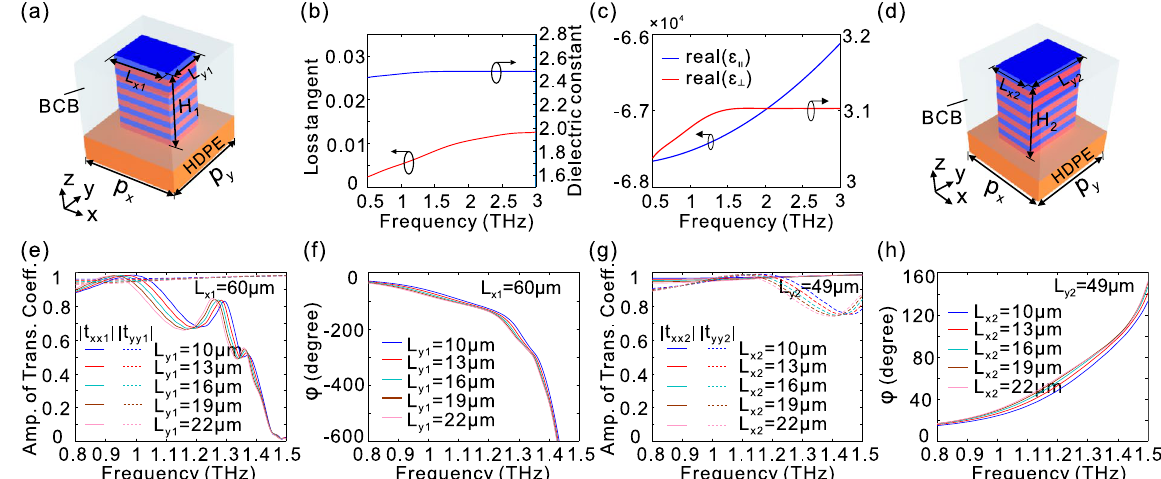
Figure 1. The amplitude of transmission coefficients and phase delay for HMM waveguide arrays. ( a ) Schematic of a unit cell of an HMM waveguide array with length L x1 , width L y1 , and height H 1 . The lattice constants along x, y, and z directions are p x , p y , and p z ( = t m + t d ), respectively. t m and t d represent the thicknesses of the metal and dielectric layers, respectively. ( b ) The loss tangent and dielectric constant of polymer BCB used in our work. ( c ) The real part of the effective dielectric permittivities ( ε || , ε ⊥ ) for the HMM considered. ε and ε ⊥ represent the effective dielectric permittivities perpendicular and parallel to the normal direction ∥ of the layered structure, respectively. The thicknesses of the metal and dielectric layers are set to be t m = 1 μ m and t d = 4 μ m, respectively. ( d ) Schematic of a unit cell of a HMM waveguide array with length L y2 , width L x2 , and height H 2 . Dependence of the amplitude of transmission coefficients | t xx 1 | (solid lines), | t yy 1 | (dashed lines) ( e ), and phase delay ( f ) on L y1 with L x1 = 60 μ m, p x = p y = 80 μ m, H 1 = 50 μ m. Dependence of the amplitude of transmission coefficients | t xx 2 | (solid lines), |t yy 2 | (dashed lines) ( g ), and phase delay ( h ) on L x2 with L y2 = 49 μ m and H 2 = 50 μ m. The other structural parameters are the same as those in ( e ). The simulation work is conducted by numerical simulations with Lumerical FDTD solutions [see the detail in the Methods